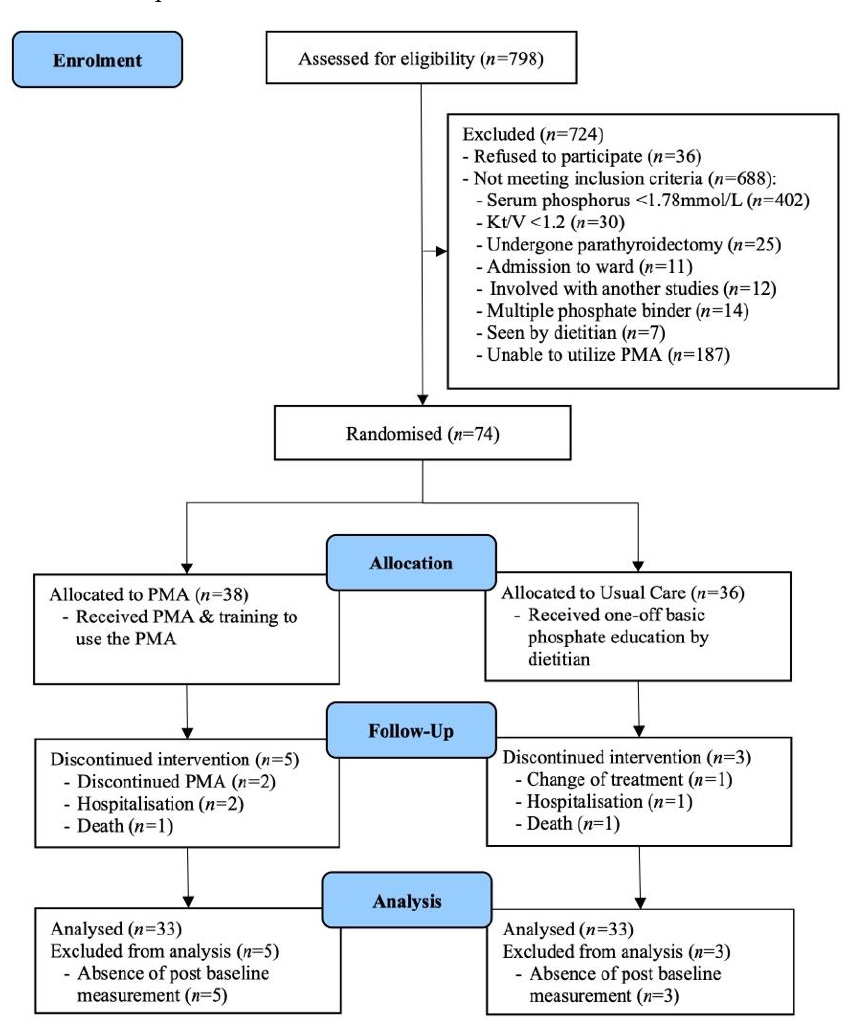
Figure 1. Flow diagram of the study. Abbreviation: PMA, phosphate mobile application.